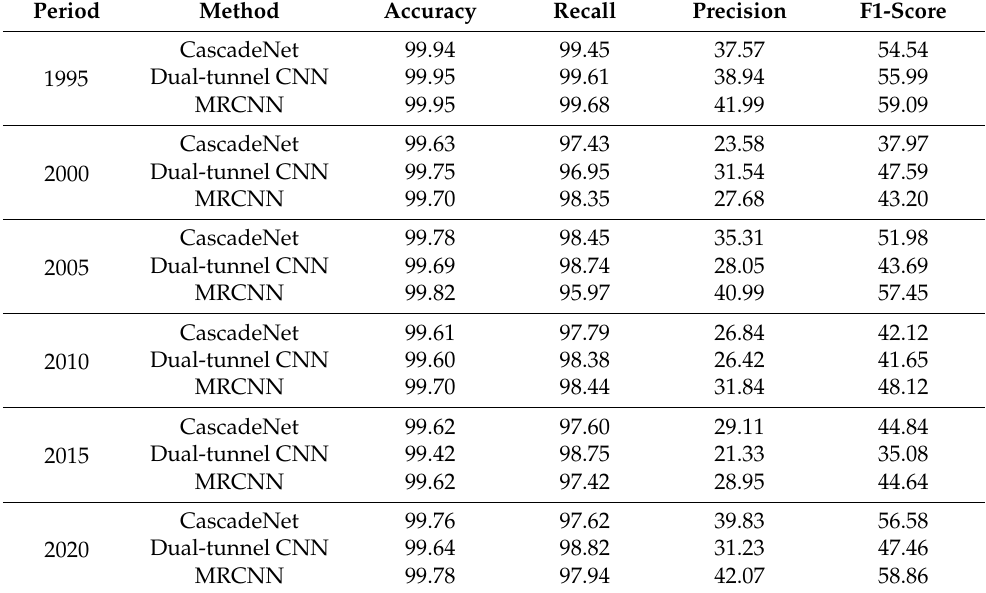
Table 4. The extraction results (%) of S. alterniflora each year along the coast of Jiangsu. Period Method Accuracy Recall